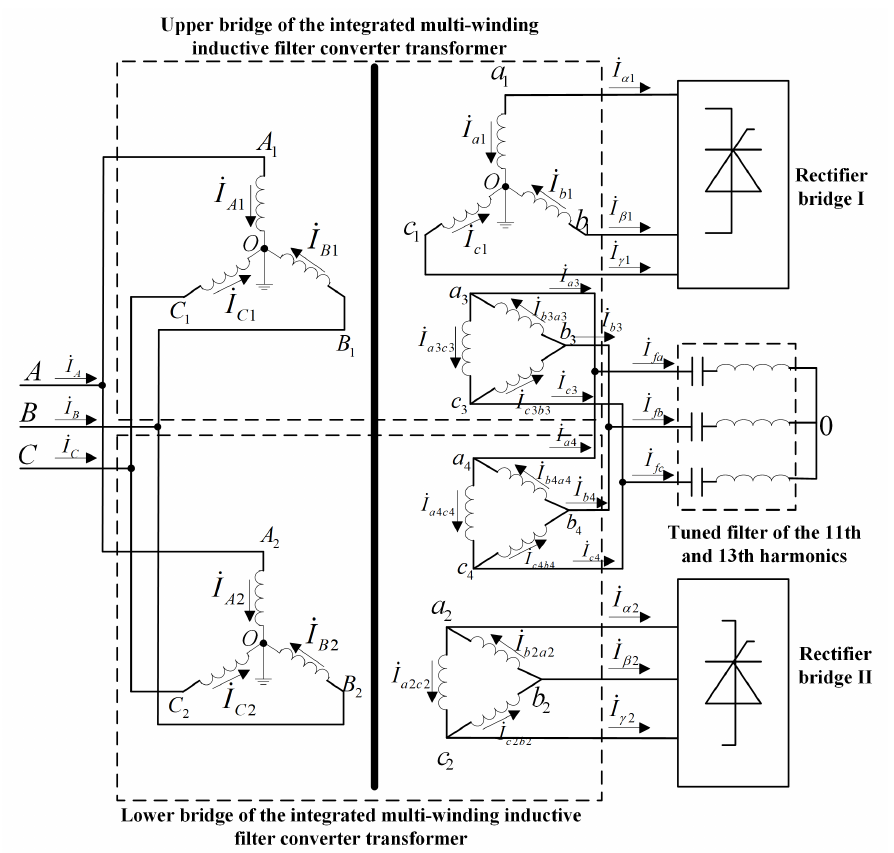
Figure 1. Wiring scheme of the integrated multi-winding inductive filter converter transformer and its filter